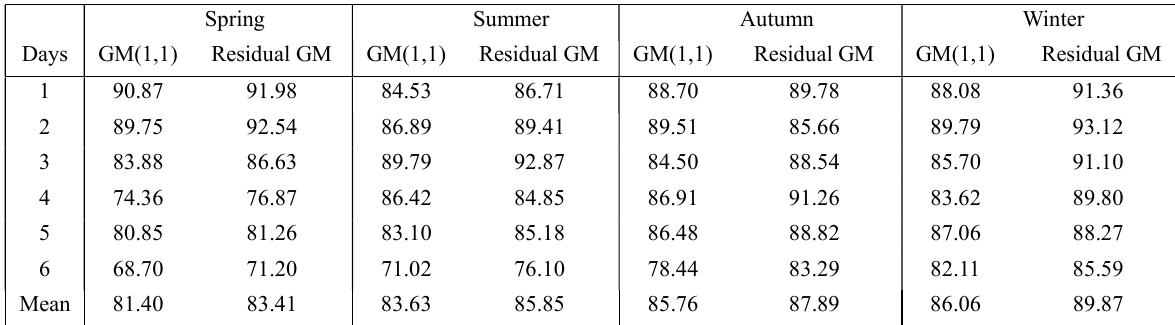
Figure 4. TEC forecast for 6 days in winter at low latitudes